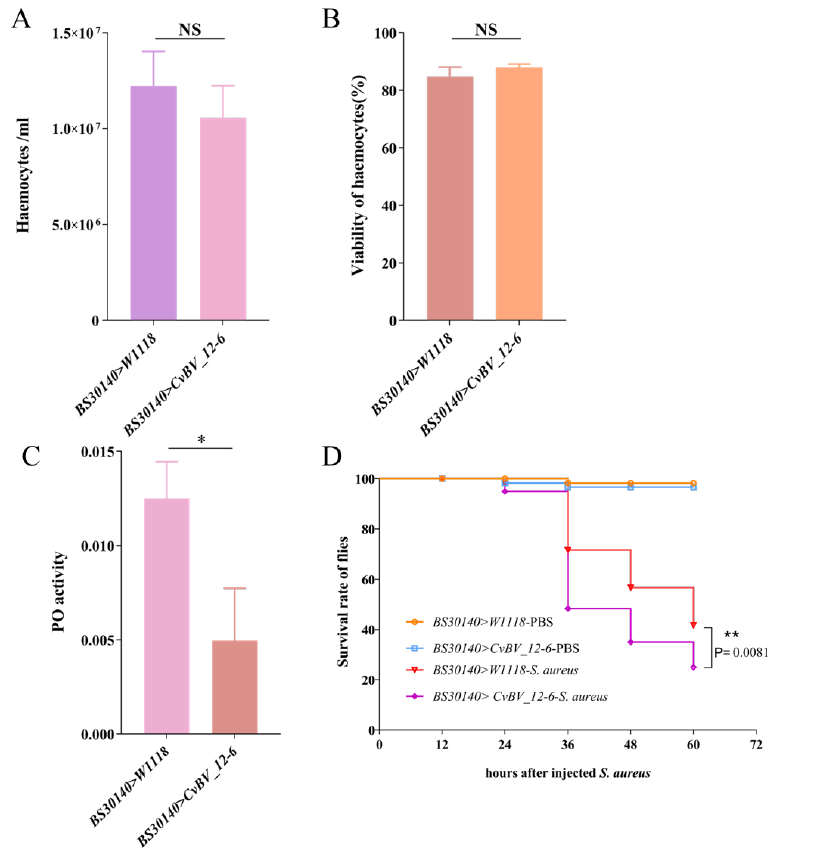
Figure 3. The immunosuppression of CvBV_12-6 in D. melanogaster . ( A , B ) The effect of CvBV_12-6 on the number ( A ) and the viability of hemocytes ( B ) in D. melanogaster . ( C ) The effect of CvBV_12-6 on the PO activity in D. melanogaster . The hemolymph was collected from third instar D. melanogaster larvae, and the PO activity was determined as a change in absorbance at 490 nm per mg protein per min. ( D ) The antibacterial activity of male D. melanogaster to S. aureus. Thirty adult Hml-GAL4 strain males and 200 adult UAS- CvBV_12-6 strain virgins were mated for 1 day and then transferred to a new food bottle every 2 h. Hml-GAL4 flies crossed with W1118 flies were the controls. Data are presented as the mean ± SD from three independent experiments. Each treatment group included 20 larvae (n = 15). Differences among samples were evaluated for significance via Tukey’s test (NS, no significance; *, significant difference at a p value < 0.05; **, significant difference at a p value < 0.01) .